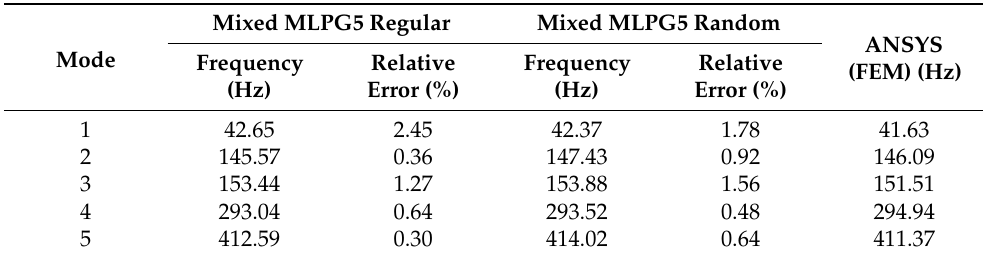
Table 1. Comparison of the natural frequencies of the variable-cross-section beam obtained by the meshless algorithm and ANSYS (FEM).